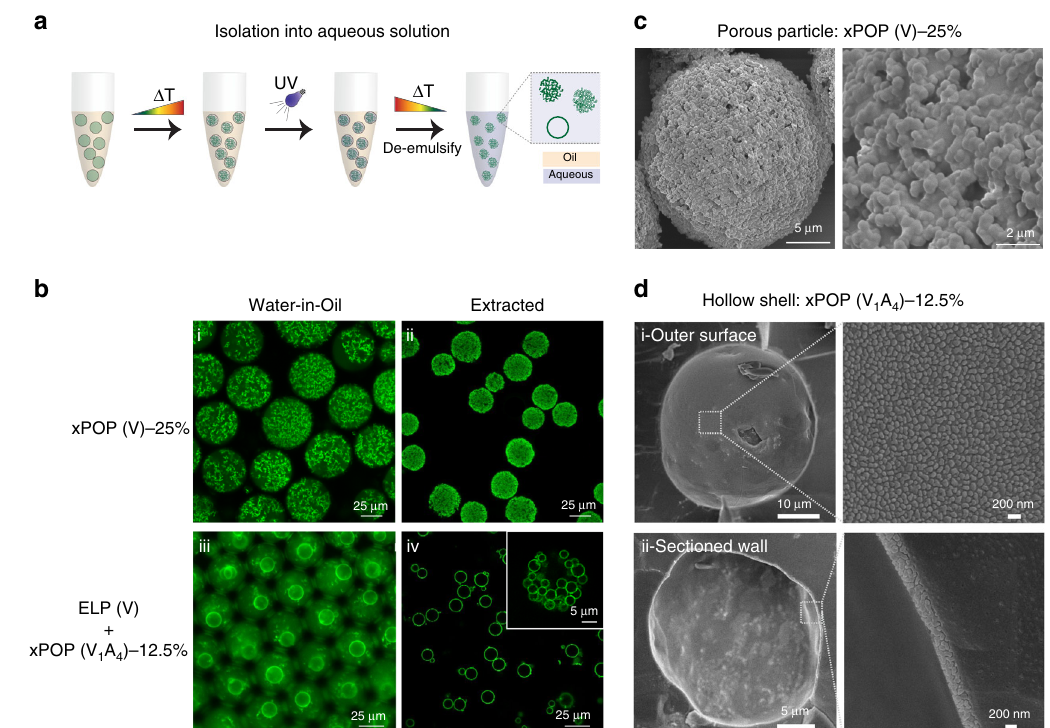
Fig. 4 Extraction into an aqueous environment. a Schematic of the process of extraction from water-in-oil to an all aqueous (buffered saline) environment. b Microscopy images of (i) unextracted (500 µ M) and (ii) extracted xPOP(V)-25% porous microparticles and (iii) unextracted and (iv) extracted xPOP shells formed from mixtures of ELP(V) (1 mM) + xPOP (V 1 A 4 )-12.5% (100 µ M) mixtures. The inset in iv demonstrates that hollow shell networks created with faster heating rates can also be extracted. c SEM of a xPOP(V)-25% microparticle showing the interconnected coacervate architecture that comprises the networked particle. d Cryo-SEM images of (i) the outer surface and (ii) a fractured xPOP (V 1 A 4 )-12.5% shell. The walls of each shell range from ~200 – 400 nm thick are composed of tightly packed nano-coacervates of